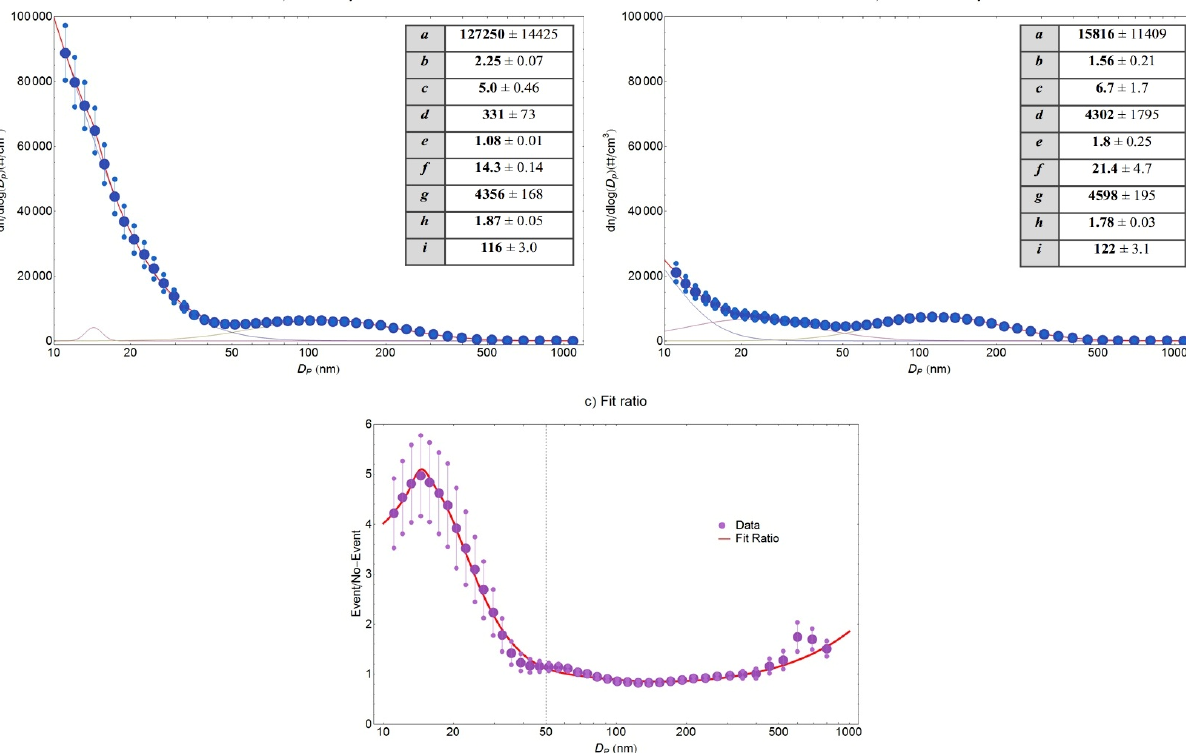
Figure 6. Fit with three lognormal distributions for the event days ( a ) and for the non-event days ( b ). The ratio between event and non-event distribution is reported in ( c ) together with a table of the best fit parameters and their standard